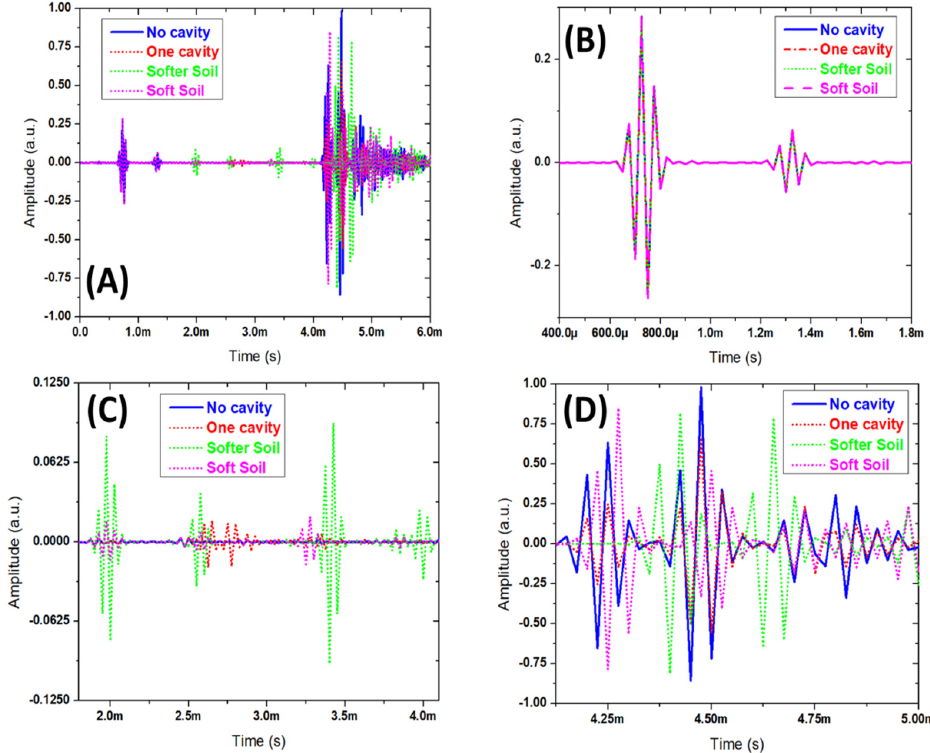
Figure 3. ( A ) Temporal reflected signal collected at the surface of the probe in all four cases mentioned in Figure 2. “No cavity” was the healthy soil condition in case ( A ). “One cavity” indicated the soil with a small air void in case ( D ). “Soft soil” was the case ( B ), which has a soft soil zone in the soil layer, which has similar properties. “Softer soil” was the case ( C ), which has a soft soil zone in the soil layer which has dissimilar properties. The time window width was 6 ms. The wave completed a roundtrip in the simulated model in the calculated time length. ( B ) was the zoomed-in view between 0.4 ms and 1.8 ms. ( C ) was the zoomed-in view between 2 ms and 4 ms. ( D ) was the zoomed-in view between 4.125 ms and 5